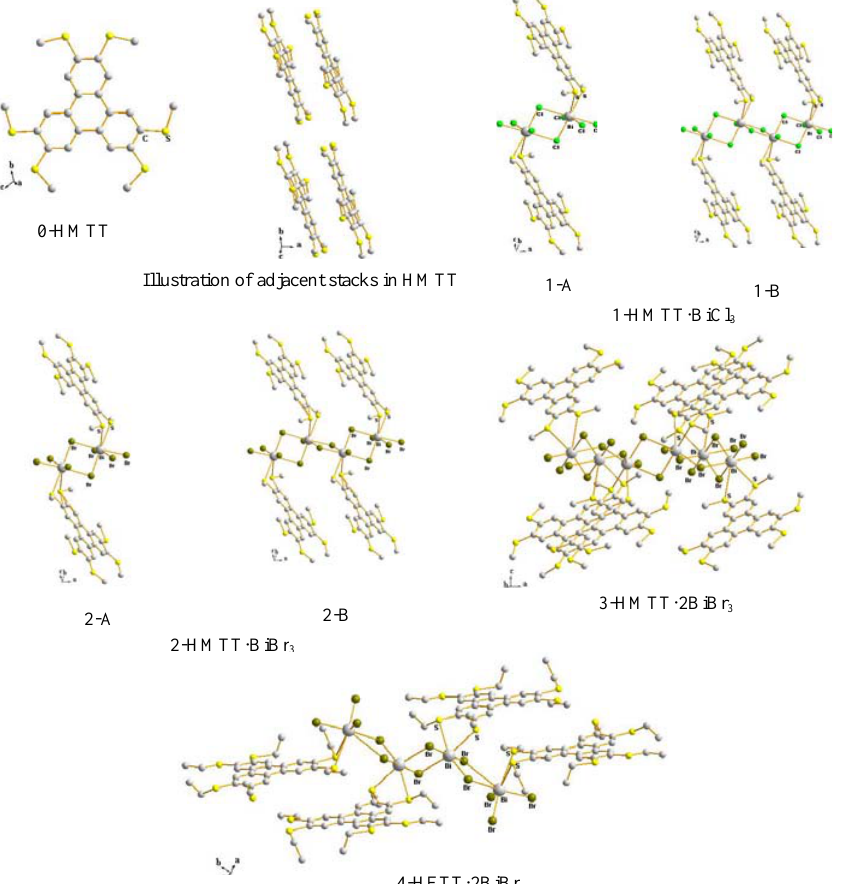
Figure 1 . Molecular structure of compounds; 0-HMTT, 1-HMTT·BiCl 3-HMTT·2BiBr , 4-HETT·2BiBr . (Hydrogen atoms were omitted for 3 3